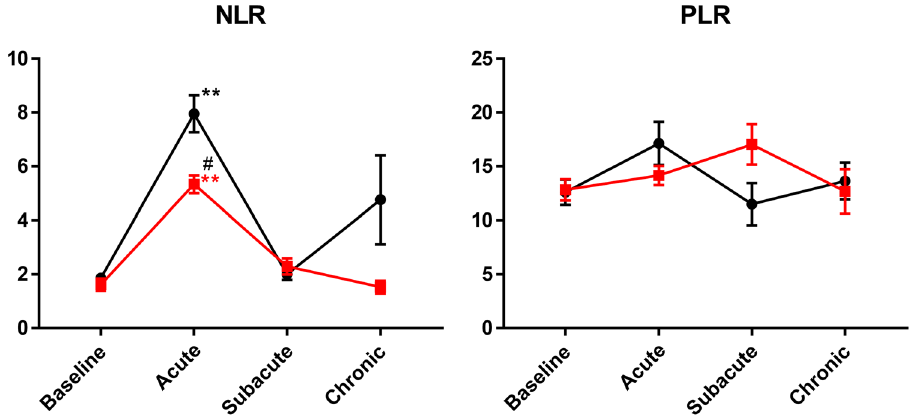
Figure 3. Changes in NLR and PLR in patient with or without cell sheet engraftment. NLR and PLR were measured before ESD, during acute phase, at subacute phase and in chronic phase after ESD. Black line represents the results from patients without cell sheet and red line represents the results from patients with cell sheet. Bars indicate average ± SEM. Dunnett test compared to baseline: **p < 0.01; Welch t test between patients with and without cell sheet: # p < 0.05. NLR neutrophil-to-lymphocyte ratio, PLR platelet-to-lymphocyte ratio, ESD endoscopic submucosal